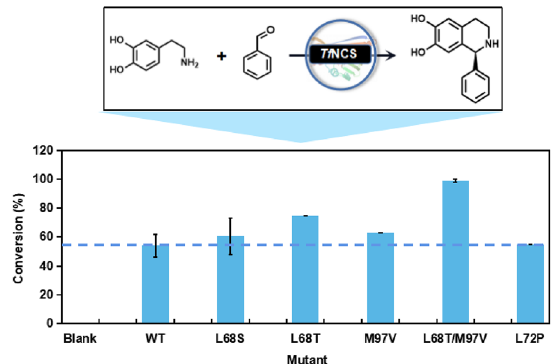
Fig. 5 Biotransformation of benzaldehyde and dopamine catalysed by Tf NCS and its mutants. The reaction mixture was composed of 10 mM amine, 1 mM aldehyde, 20% (v/v) DMSO, 5 mM ascorbic acid,